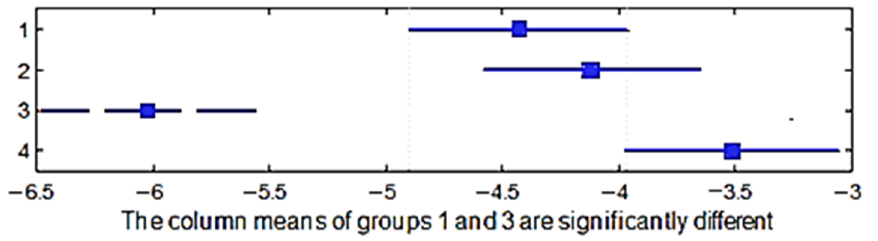
Figure 10. Confidence intervals of the shrinkage in the warp direction of different weave groups.